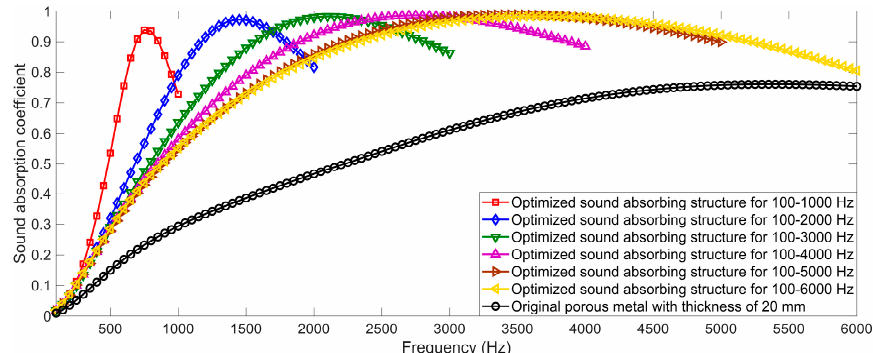
Figure 9. Comparisons of the theoretical sound absorption coefficients of the optimized composite sound-absorbing structures and those of the original porous metal.